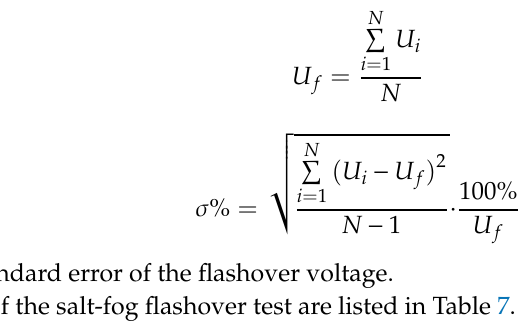
Table 7. The results of salt-fog flashover voltage of samples of Factory A. Samples